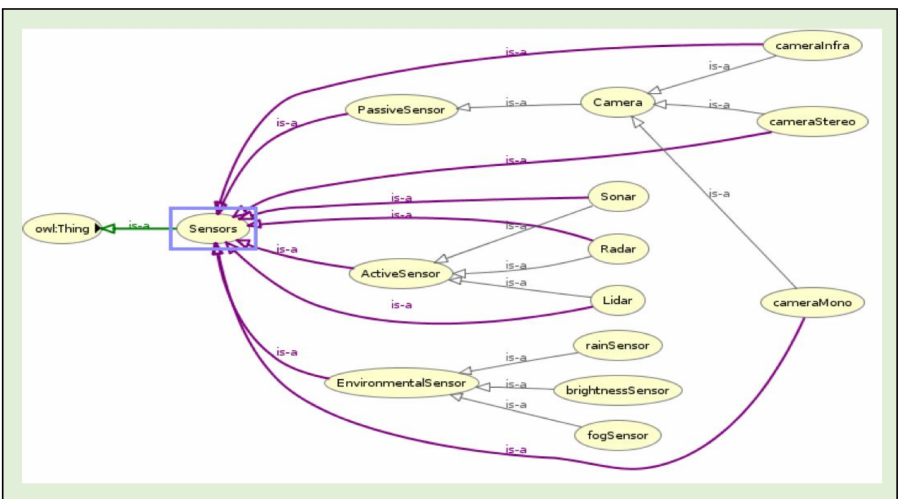
Figure 11. Relationships and properties of the Sensors class in the ontology. Following the notion of object-oriented programming, the arrow here denotes inheritance.